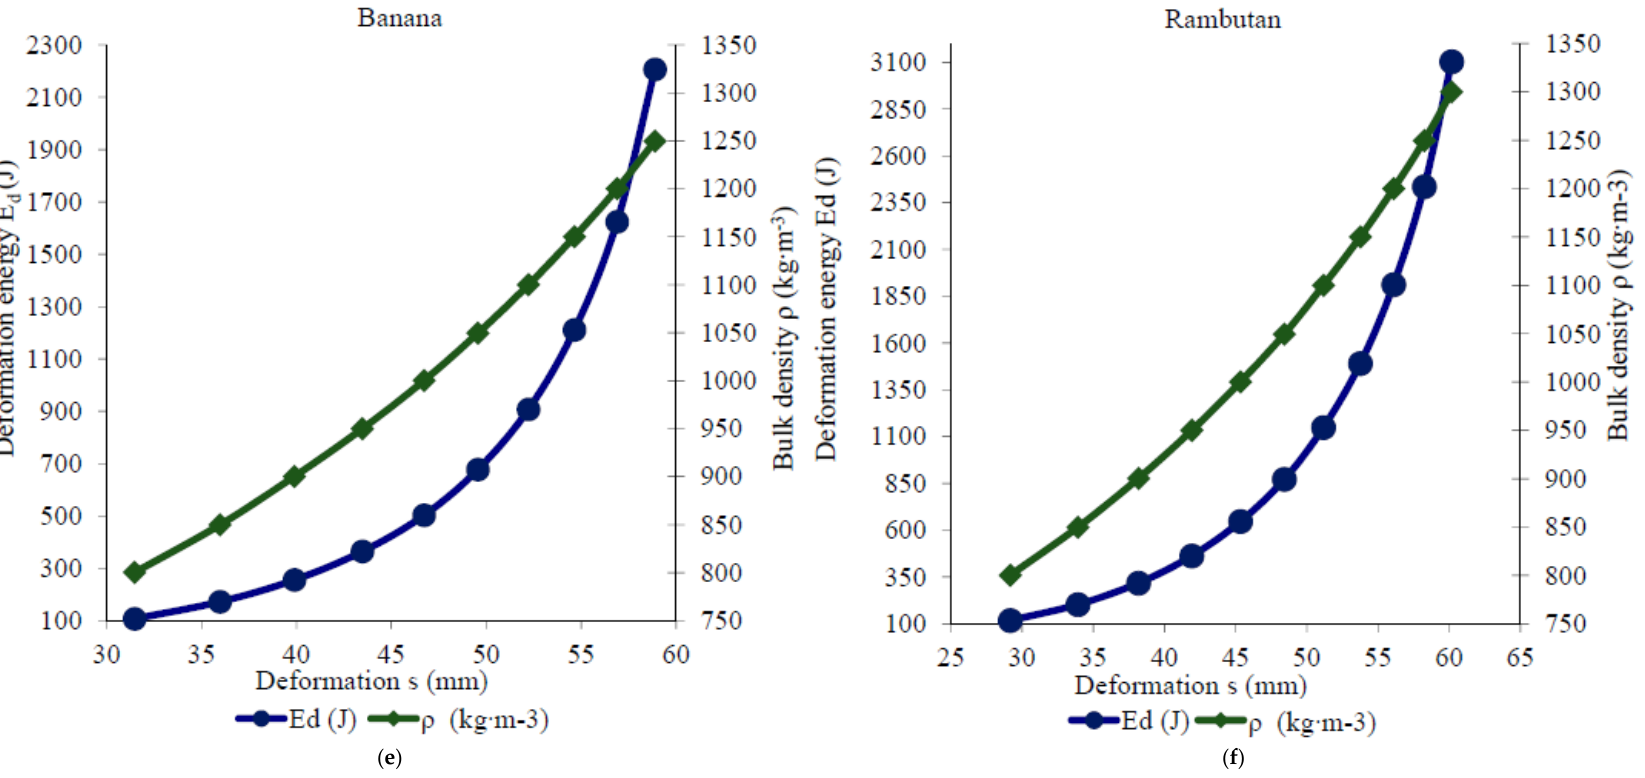
Figure 6. Intersection of required deformation energy E d (J) and bio-briquette bulk density ρ (kg∙m −3 ) curves determining efficiency of bio-briquette production from fruit waste biomass of the following tropical fruit: ( a ) durian, ( b ) coconut, ( c ) cacao, ( d ) coffee, ( e ) banana, and ( f ) rambutan.